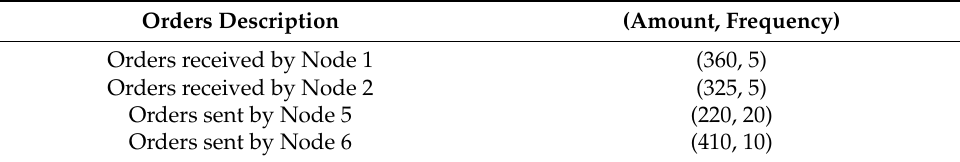
Table 6. Orders related to the outside of the network in Topology 1.